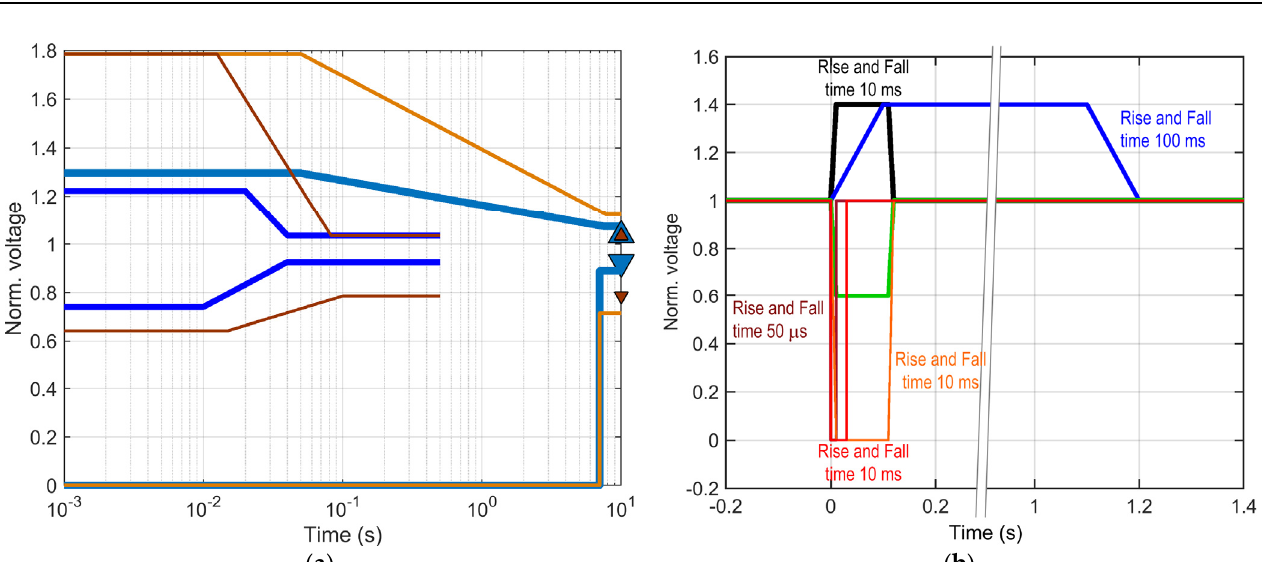
Figure 3. Profile of allowed transient overvoltage/undervoltage: ( a ) avionics (in blue the normal range and in brown the exceptional range, dark for 270 Vdc and light for 28 Vdc systems; the triangles indicate the permanent network voltage excursion around nominal values; MIL-STD-704F [107]); ( b ) railways (overlapped curves of immunity tests as per Figure 6 through 11 of EN 50155 [116]; colors just distinguish the profiles with no particular meaning).